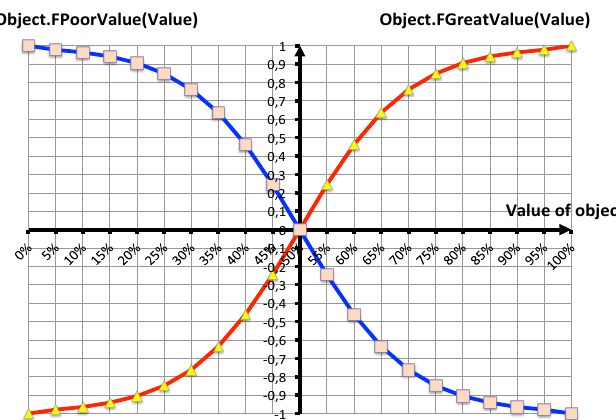
Figure 8. Value of the object membership functions: FpoorValue() and FgreatValue() .